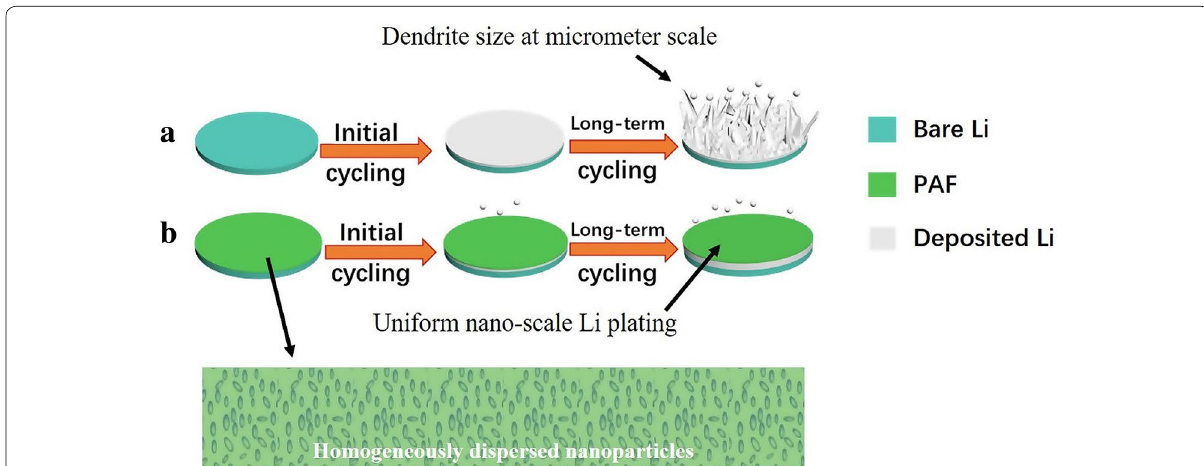
Fig. 1 Schematic illustration of Li deposition on a bare Li foil during plating, forming micron-sized Li dendrites; and b PAF-protected Li foil, where PAF is composed of organic PVDF-HFP and homogeneously dispersive inorganic AlPO 4 nanoparticles. Consequently, Li-ions are homogeneously redistributed in the film before Li plating, leading to uniform Li plating at nanometer